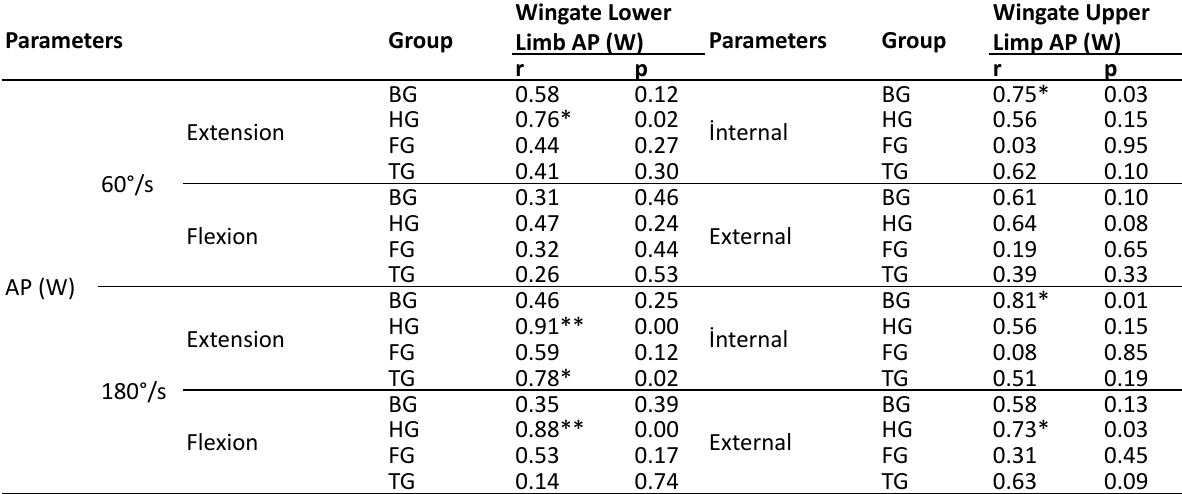
Table 4. The correlation analysis of the participants’ wingate data and dominant arm and leg 60°/s and 180°/s rotation isokinetic data categorized in